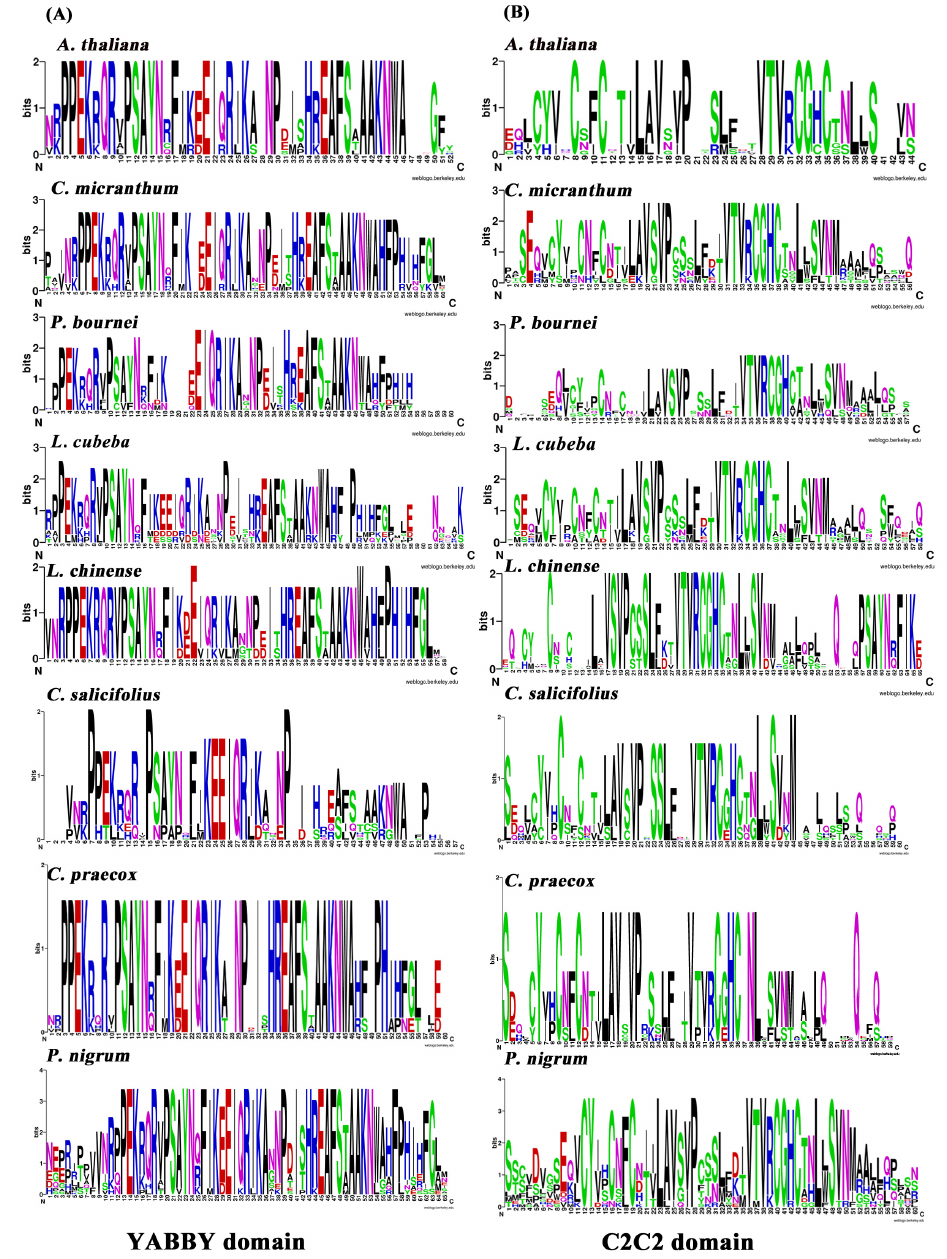
Figure 1. Conserved domain of seven magnoliids and Arabidopsis thaliana YABBY protein sequences. ( A ) Sequence logo showing the C-terminal conserved YABBY domain. ( B ) Sequence logo revealing the N-terminal conserved zinc-finger